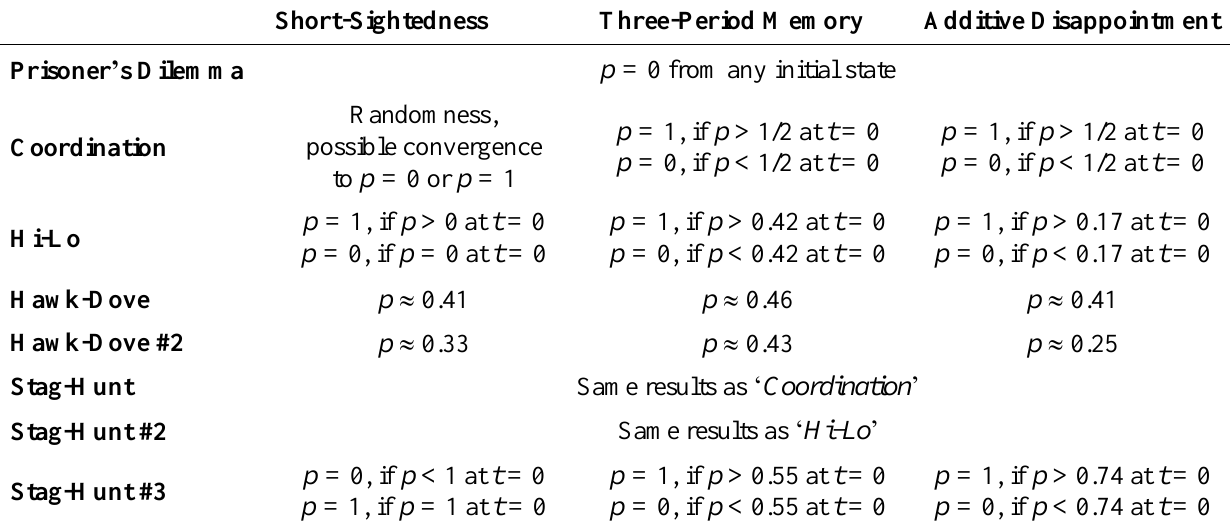
Table 3. Simulation results in the case without random